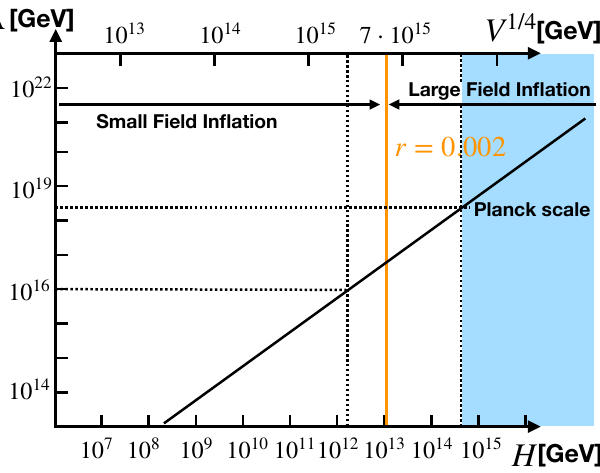
Figure 7 . Cutoff scale Λ 4pt vs Hubble scale H : as a benchmark point, we plot Λ 4pt = 6 × 10 3 H , which corresponds to the choice | ˙ θ 0 /H | = 0 . 1 , h ( ν ) = 10 , and | f NL | = 1 . The blue region corre- sponds to Λ 4pt ≥ M pl